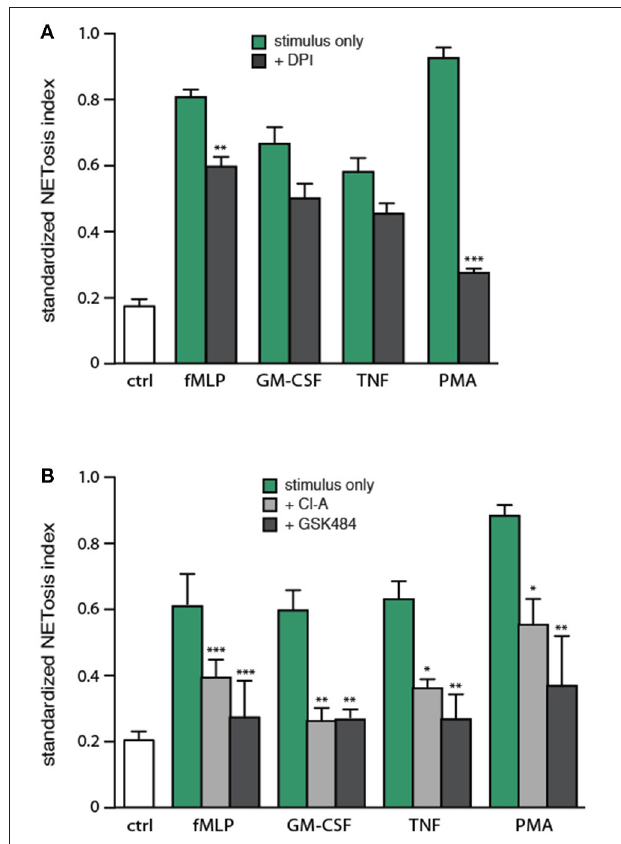
FIGURE 6 | Involvement of endogenous ROS and PAD4 in NET generation. (A) Neutrophils cultured on poly-L-lysine-coated coverslips were pre-treated (15min, 37 ◦ C) with 10 µ M DPI or its diluent (DMSO), prior to a further incubation of 4h in the absence (“ctrl”) or presence of 30nM fMLP, 1nM GM-CSF, 100 U/ml TNF α , or 50nM PMA. NETosis was then assessed using PlaNET Green as described in Methods . Quantitative representation of these experiments, expressed as NETosis index. Mean ± s.e.m. from at least 5 independent experiments. ** p < 0.01 and *** p < 0.0001 vs. stimulus alone. (B) Neutrophils cultured on poly-L-lysine-coated coverslips were pre-treated (15min, 37 ◦ C) with 10 µ M chloraminidine (“Cl-A,” a general PAD inhibitor), 10 µ M GSK484 (a PAD4 inhibitor), or their diluent (DMSO), prior to a further incubation of 4h in the absence (“ctrl”) or presence of the above